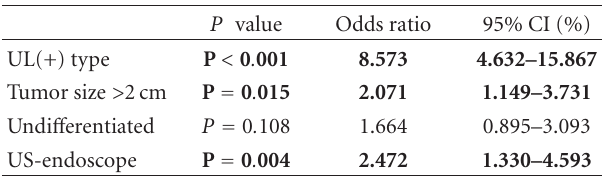
Table 4: Multivariate analysis of factors a ff ecting accuracy of the determination of the depth of cancer